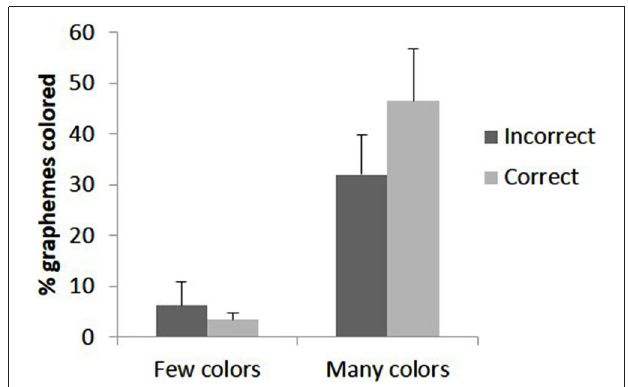
FIGURE 4 | The mean intensity of colors (1 = no color, 6 = vivid color) reported for trials in which the embedded figure was correctly or incorrectly detected dependent on whether the participant saw many colors or few colors . Error bars represent 1 SEM.